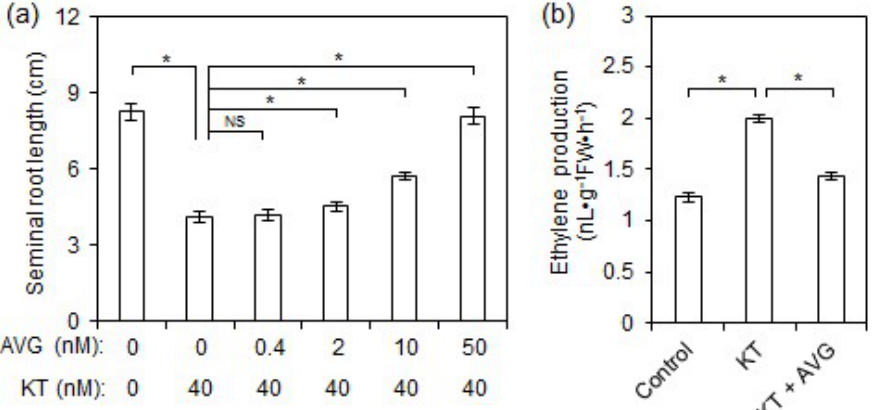
Figure 2. Mitigating effects of aminoethoxyvinylglycine (AVG) on KT-induced root growth inhibition and ethylene production in rice seminal roots. Germinated rice seeds were incubated in a solution of KT, KT + AVG, or distilled water as a control. After 4 days of growth, we measured the lengths of seminal roots and the amount of ethylene produced. Seminal root length and ethylene production were calculated from nine and three biological replicates, respectively. Data are presented as means ± SE, and significant differences ( p < 0.05) between various treatments are indicated by asterisks. ( a ) Mitigating effect of AVG on KT-induced root growth inhibition. ( b ) Mitigating effect of AVG on KT-induced ethylene production. KT, treatment of 40 nM KT; KT + AVG, treatment of 40 nM KT plus 50 nM AVG; FW, fresh weight. NS, no significance.